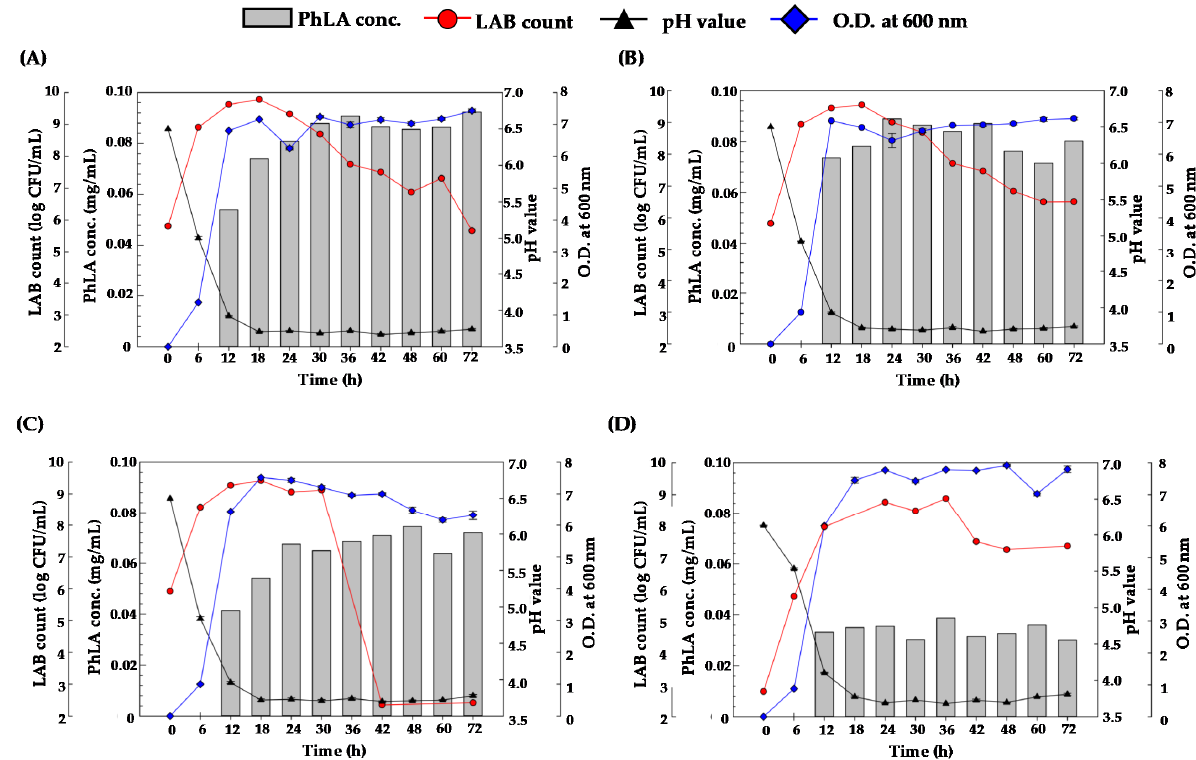
Figure 1 . The lactic acid bacteria (LAB) count, PhLA concentration, optical density (O.D.) at 600 nm, and pH value of cell-free supernatant of ( A ) Lactobacillus plantarum KP4, ( B ) L. plantarum KP3, ( C ) Leuconoctoc mesenteroides K8, and ( D ) L. paracasei subsp. paracasei DP2 in de Man, Rogosa and Sharpe (MRS) medium incubated at 37 °C for 0–72 h.